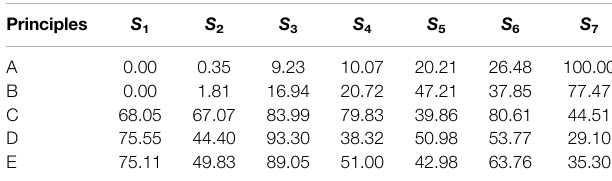
TABLE 3 | Evaluation results under fi ve